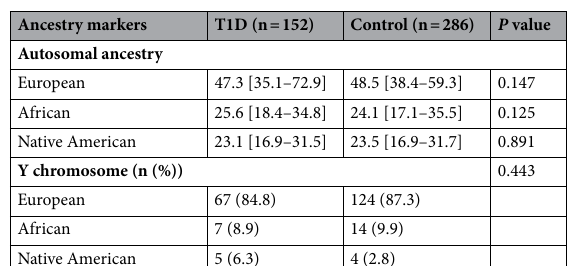
Table 2. Distribution of ancestry markers of the Maranhão state T1D and control groups. Data are presented as number (percentage), median [IQR]. T1D type 1 diabetes.